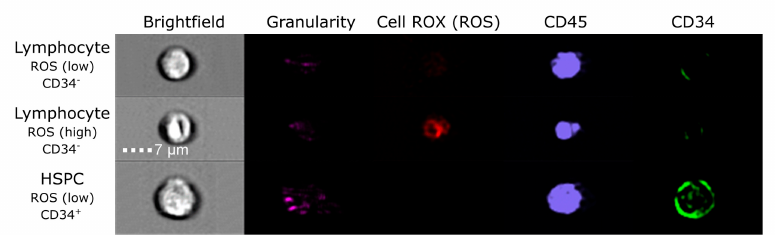
Figure 2. Representative images of ROS in RUNX1-RUNX1T1 PFG + UCB samples analyzed by ImageStream. Brightfield as forward scatter, granularity as side scatter, Cell ROX as indicator of ROS level, CD45 antibody for lymphocytes, and CD34 antibody against hematopoietic stem progenitor cells (HSPCs) are visualized.